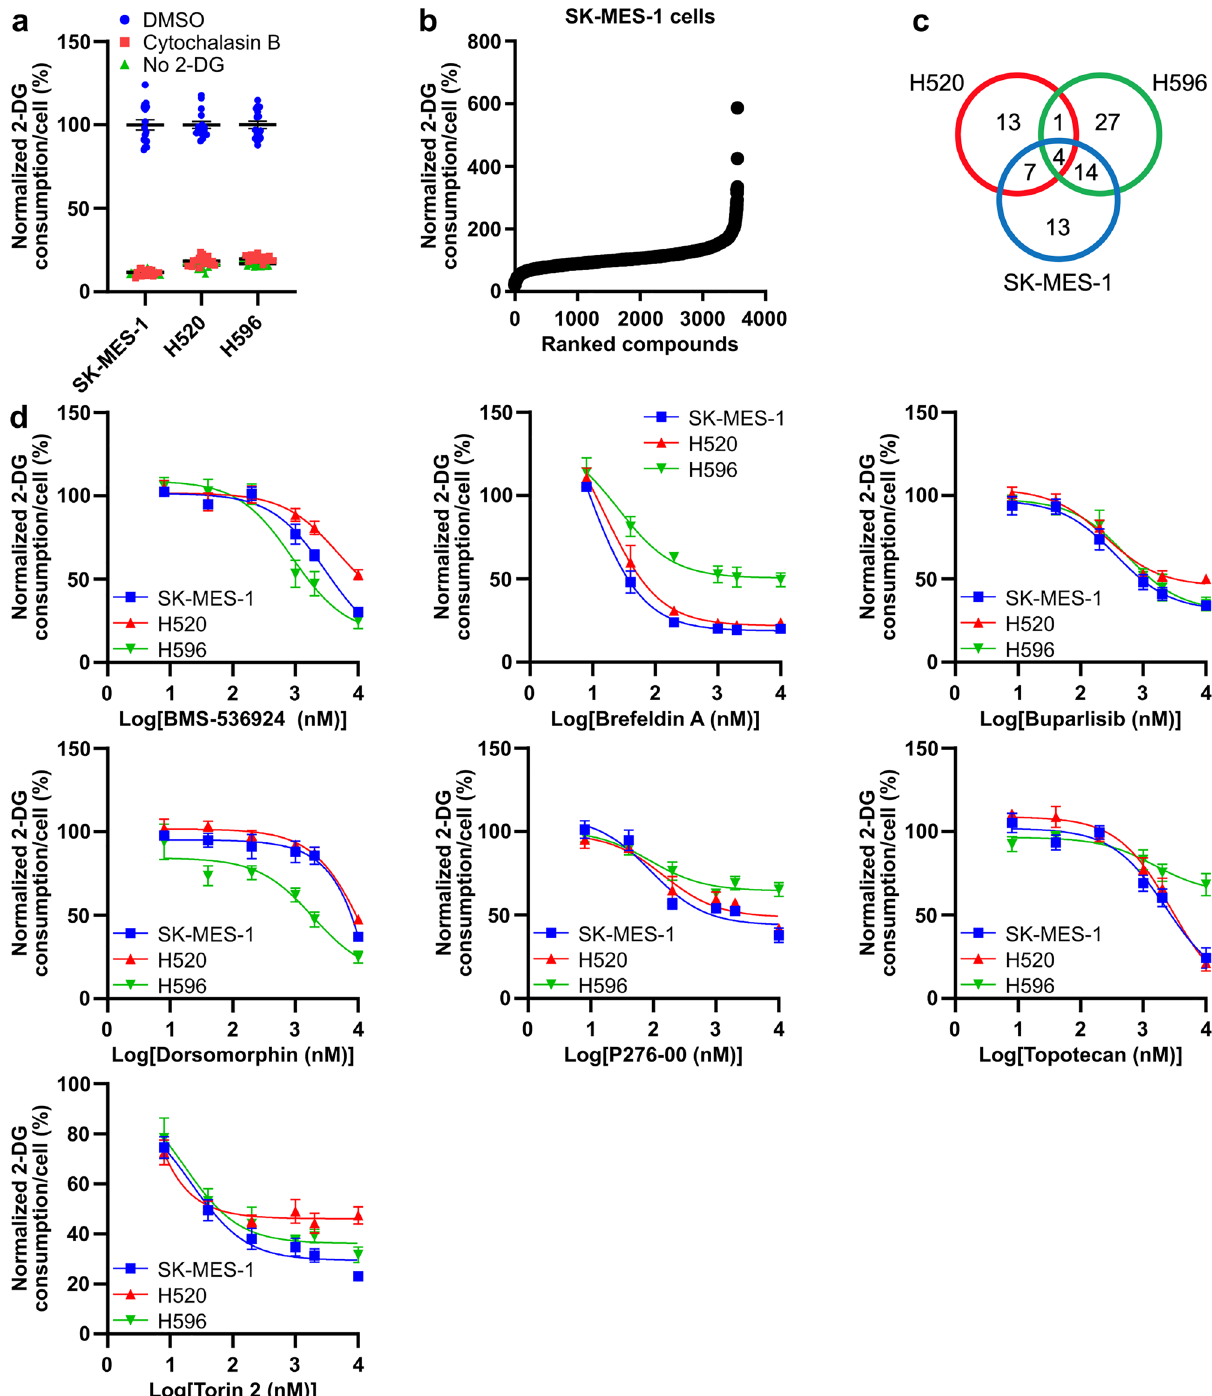
Figure 1. A high-throughput screen identifies small molecule inhibitors of squamous cell lung cancer glucose consumption. ( a ) Glucose consumption in SK-MES-1, H520, and H596 cells, as determined using a high- throughput glucose consumption assay that measures 2-DG-6-phosphate levels in 2-DG treated cells. Cells were treated with DMSO, Cytochalasin B, or without 2-DG. ( b) A waterfall plot of glucose consumption in SK-MES-1 cells treated with 3555 compounds. ( c ) The number of unique and shared compounds that inhibit glucose consumption by > 50% in SK-MES-1, H520, and H596 cells. ( d ) Dose–response curves of glucose consumption in SK-MES-1, H520, and H596 cells treated with BMS-536924, Brefeldin A, buparlisib, dorsomorphin, P276-00, topotecan, and Torin